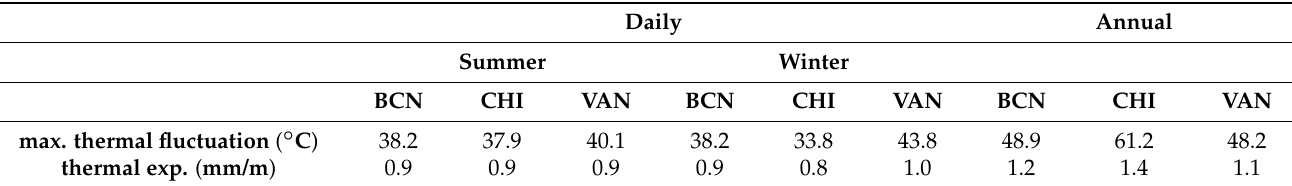
Table 9. Maximum thermal fluctuations and thermal expansion of louvres.